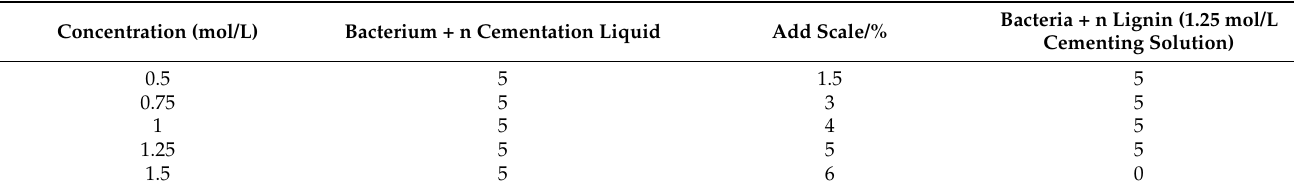
Table 2. Statistics of the number of samples